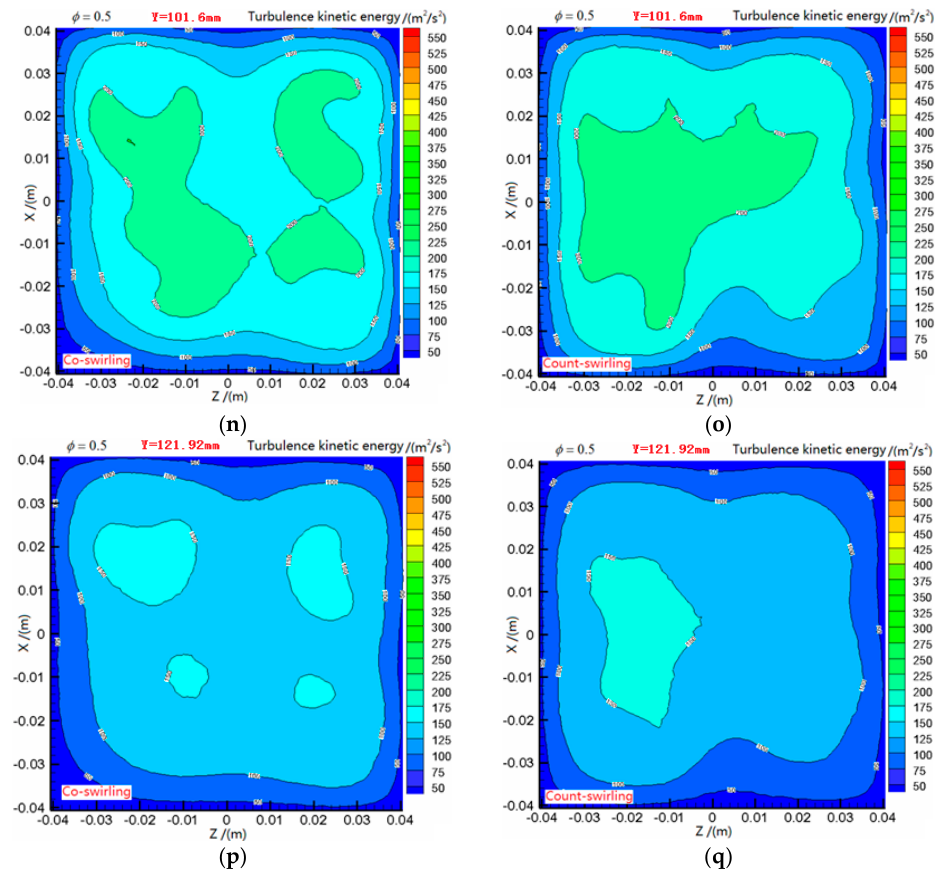
Figure 6. Turbulence kinetic energy contours compared for count-swirling four-point LDI combustors with different equivalence ratios.